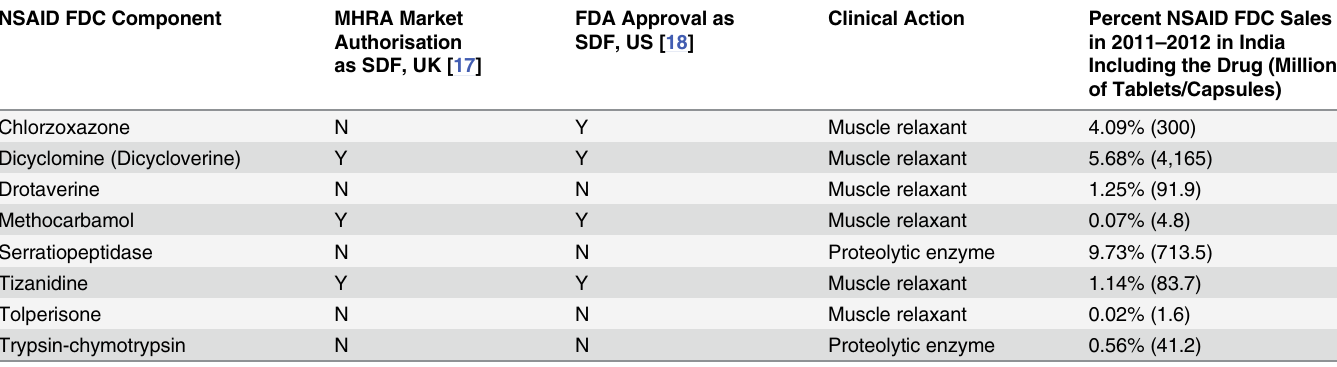
Table 6. Muscle relaxants and proteolytic enzymes included in NSAID FDC formulations marketed in India.